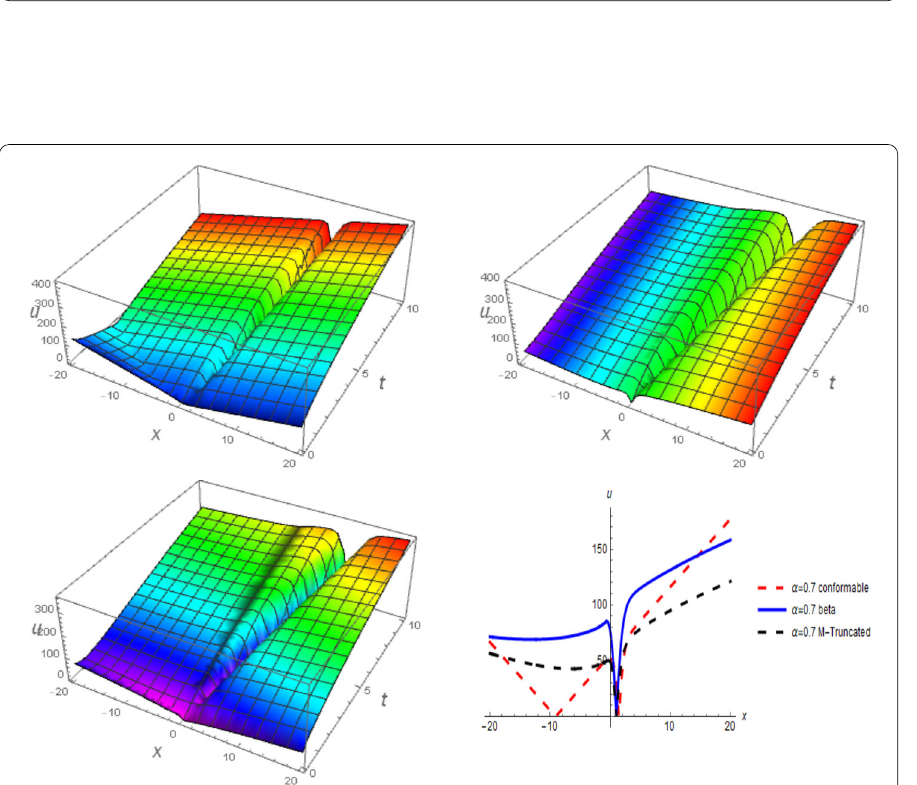
Figure 2 ( a ) 3D-plot of u 1 for conformable, ( b ) 3D-plot of u 1 for beta with α = 0.7. ( c ) 3D-plot of u 1 for M-truncated with α = 0.7, ( d ) 2D-plot of u 1 with t =